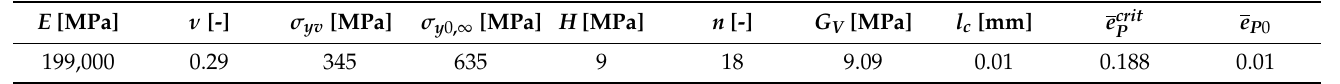
Table 2. Material parameters used for phase-field damage model simulation.